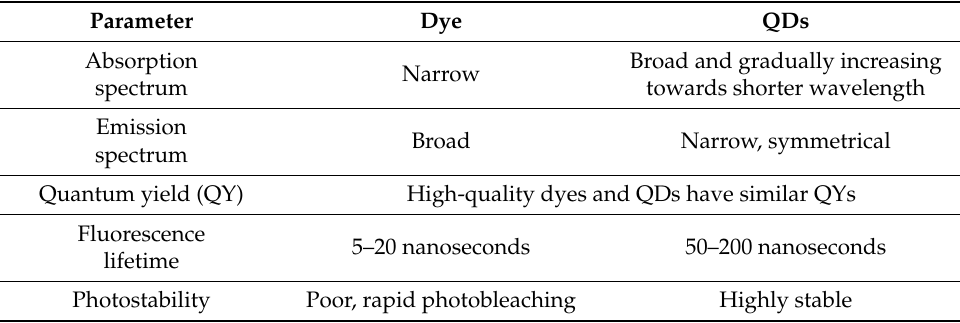
Table 4. Optical parameters of organic dyes and